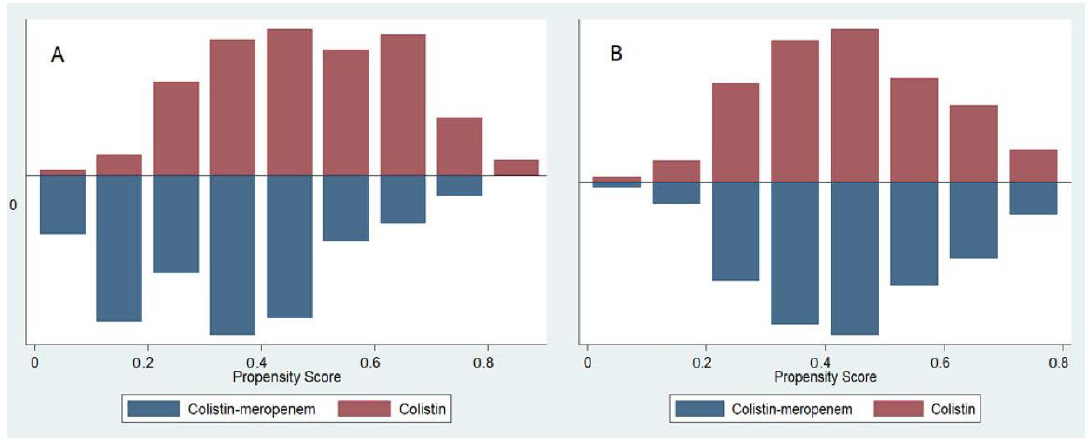
Figure 1. Distribution of propensity scores before matching ( A ) and after matching ( B ).